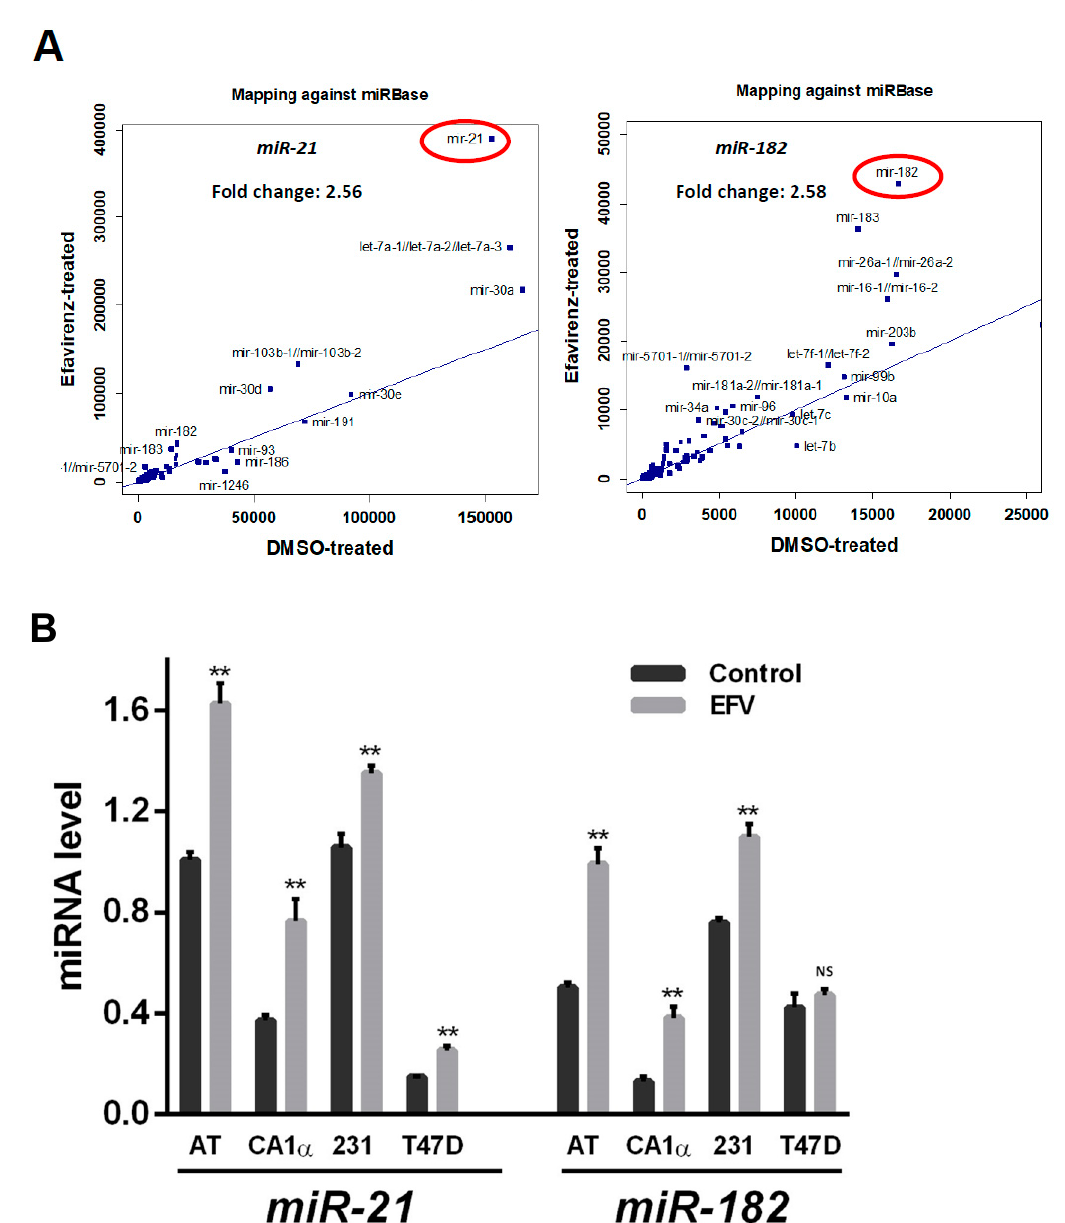
Figure 3. miRNA changes in Efavirenz-treated breast cancer cells. ( A ) Scatter plot based on microarray analysis. Efavirenz- treated T47D cells versus untreated-control T47D cells (DMSO). Blue symbols denote miRNAs. miR-21 and miR-182 have greater fold changes than other miRNAs. ( B ) microRNA RT-qPCR analysis for miR-21 and miR-182 in Efavirenz-treated and untreated MCF10AT, MCF10CA1 α , MDA-MB-231 and T47D cells. miR-21 and miR-182 qPCR results were normalized with an internal control miR-423. Error bars: ± SD, n = 3. (paired Student’s t -test, * p < 0.05; ** p <0.01).